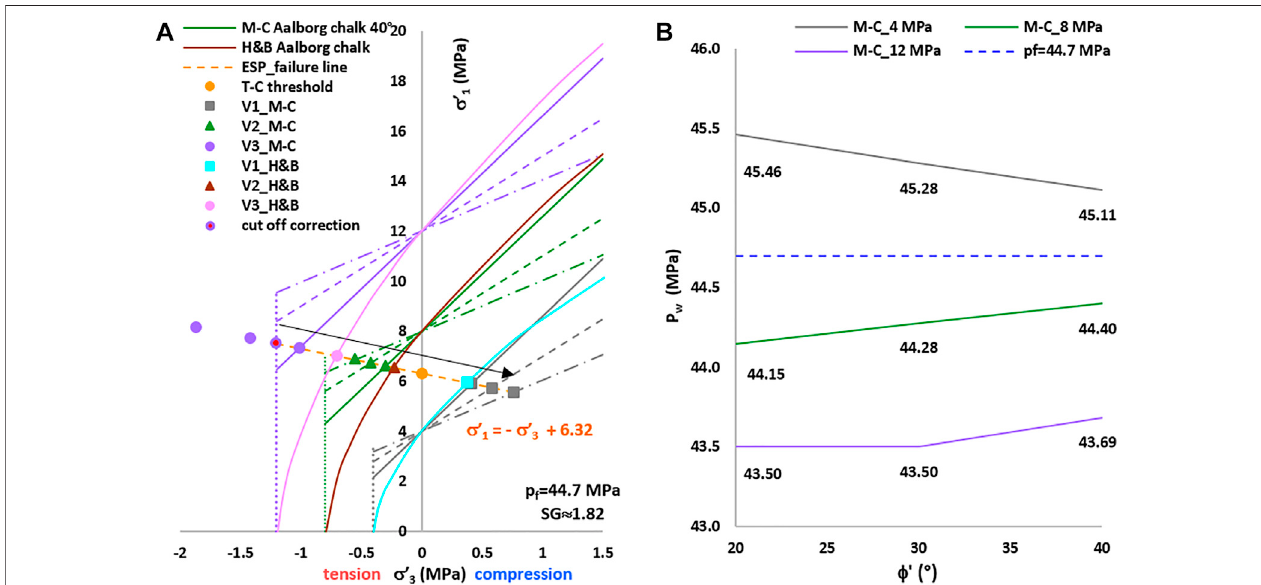
FIGURE 7 | (A) Strength envelopes of the chalk with σ c = 4-8-12 MPa, and σ c / σ t ≈ 10. The pink, brown, and turquoise lines represent the H&B strength envelopes with m t = 10.The violet, green, and grey lines representthe M-Cstrength envelopes with ϕ ′ =20 ° -30 ° -40 ° .The principalstresses are σ ′ r = P w – p f = σ ′ 3 and σ ′ ϑ =S − P w − p f = σ ′